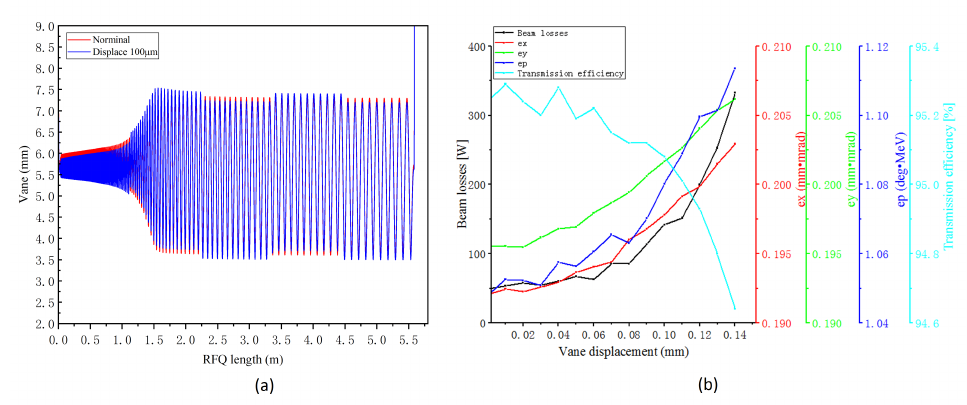
Figure 5. Vane alignment error. ( a ) Electrodes’ envelope, ( b ) Simulation